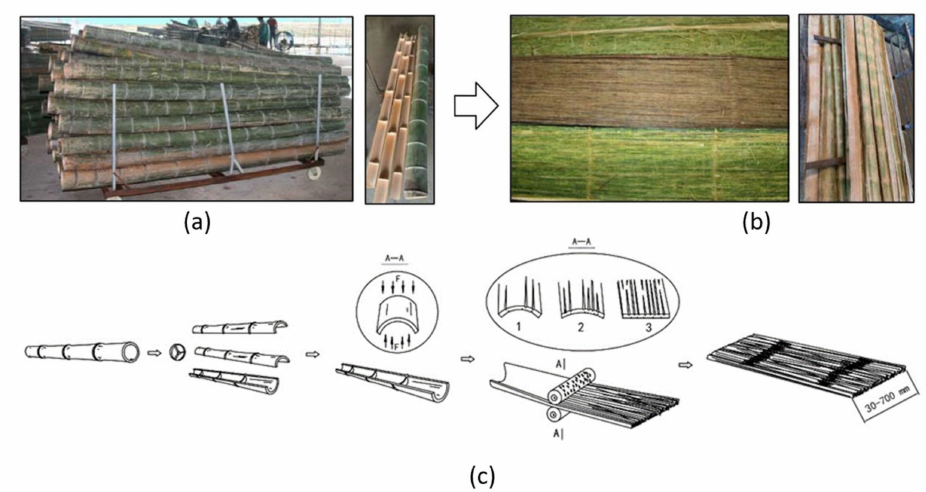
Figure 1. Culm conversion to “scrimmed” strips: ( a ) photos of culm splitting, ( b ) photos of scrimmed bamboo mats, and ( c ) schematic of the entire scrimming process where a bamboo culm was slipped into strips and then crushed into partially separated fiber mats through incised